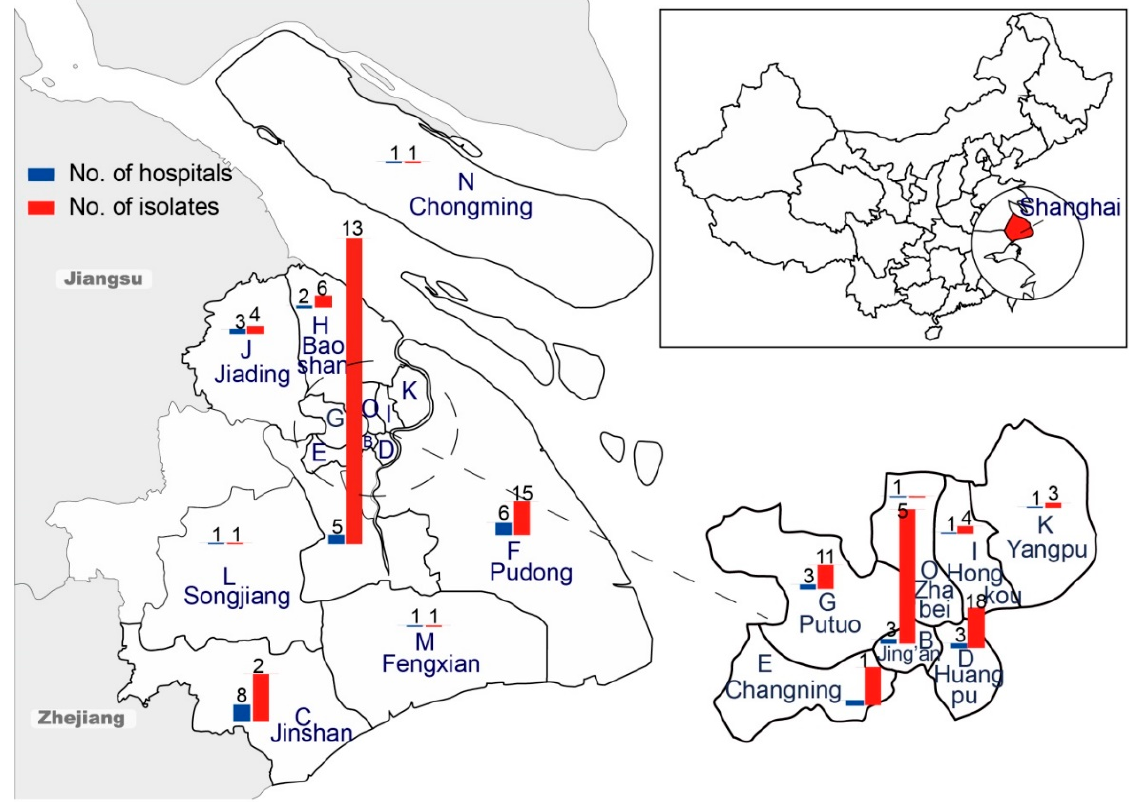
Figure 1. Origins of 292 S. enterica serovar Enteritidis isolates from 42 hospitals in 15 districts in Shanghai, China (2006–2014).